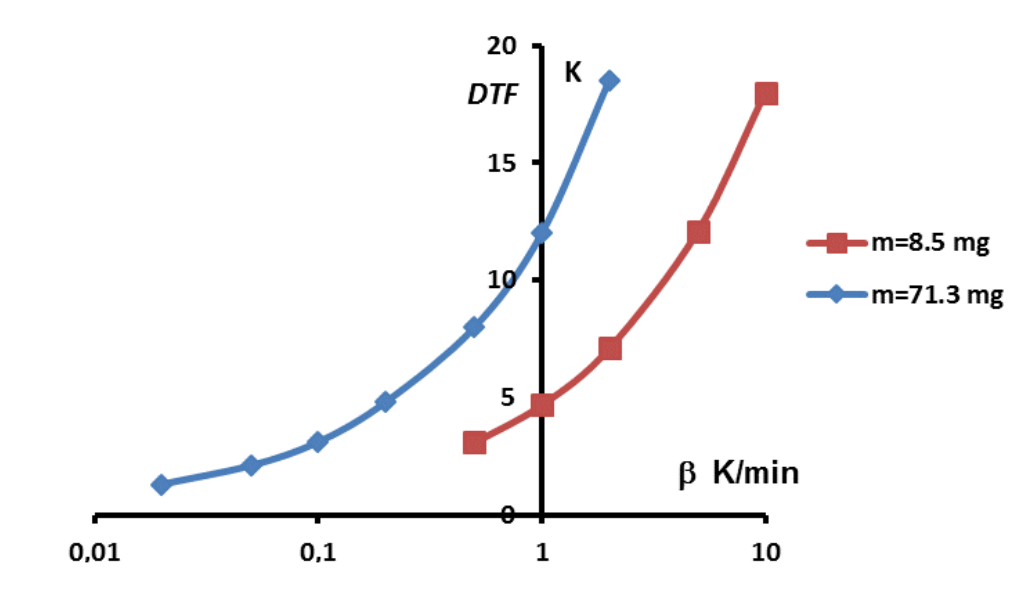
Figure 12. Peak width in function of the heating rate for various masses’